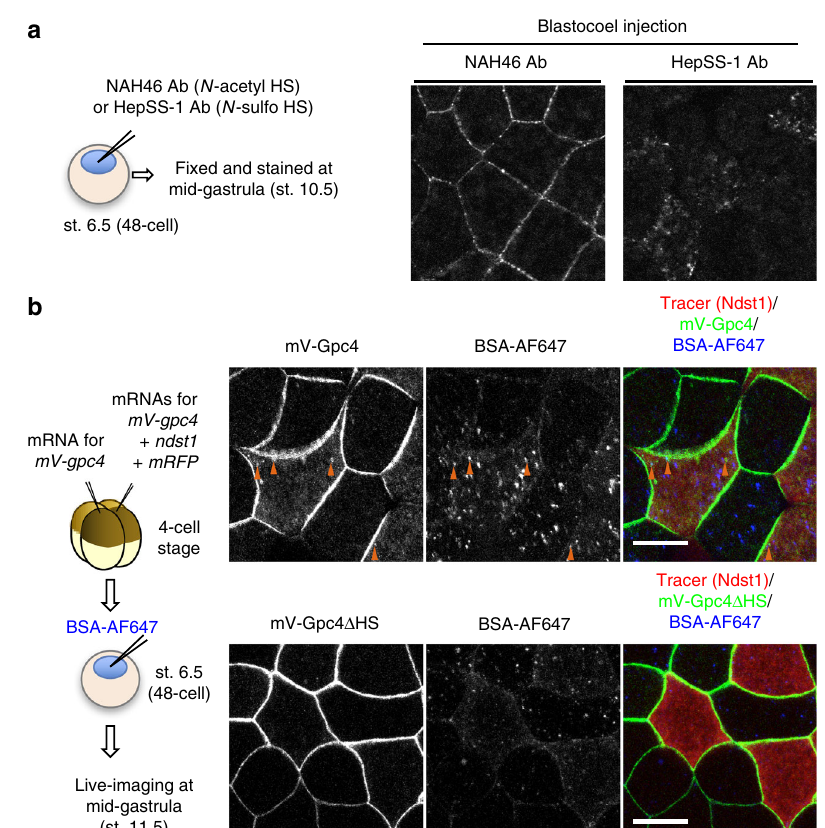
Fig. 5 N- sulfonation-dependent internalization of the HS clusters. a Internalization assay of anti-HS antibodies. NAH46 or HepSS-1 antibody (10 ng) was injected into blastocoels at st. 6.5, and the injected embryos were fi xed at st. 10.5 and stained with anti-mouse IgM secondary antibody. The animal cap region, where Wnt signaling is considered to be low 10 , was observed. Distribution of the injected anti- N- acetyl HS antibody showed an intercellular distribution similar to normal immunostaining of gastrula with the anti- N- acetyl HS antibody (Fig. 2e, Supplementary Fig. 3c), whereas that of the anti- N- sulfo HS antibody showed puncta inside the cells. b Facilitated internalization of the mV-Gpc4 core protein by coexpression of ndst1 . Dye-labeled BSA (BSA-AF647) was injected into the blastocoel as a marker for internalized puncta. The animal cap region was observed at st. 11.5. Upper panels, in ndst1 - overexpressing cells, the number of puncta of mV-Gpc4 that overlapped with BSA-AF647 (orange arrowheads) increased. Lower panels, Ndst1 did not facilitate the internalization of mV-Gpc4 Δ HS, which lacks HS chains. Amounts of injected mRNA (ng/embryo): mV-gpc4 , 0.067 × 2; ndst1 , 0.033; mRFP , 0.33. Images are a representative of at least two independent experiments. Scale bars, 20 μ m. a.u., arbitrary